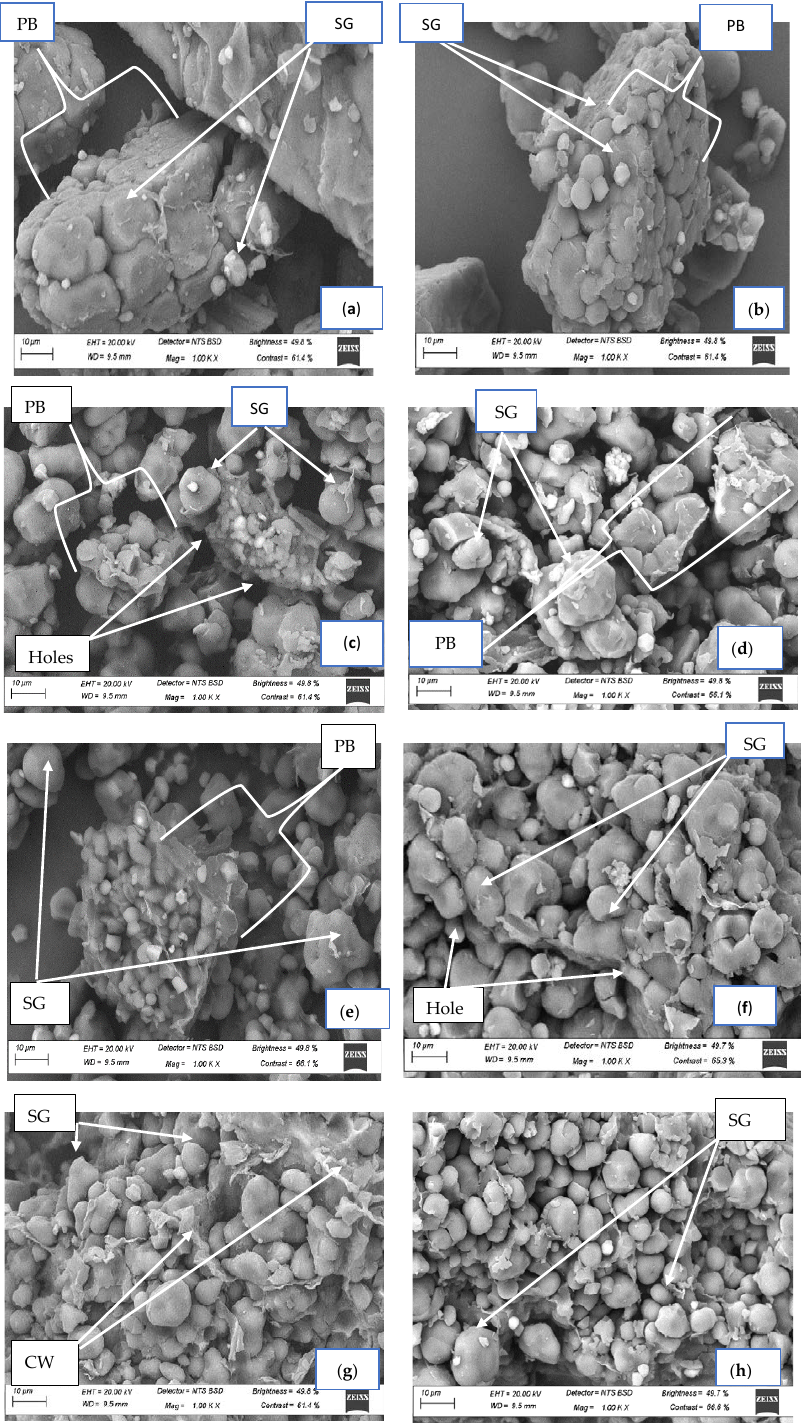
Figure 3. Scanning electron micrographs of fermented light- and dark-brown FMF: ( a ) native light-brown FMF; ( b ) native dark-brown FMF; ( c ) 24 h fermented light-brown finger millet; ( d ) 24 h fermented dark-brown FMF; ( e ) 48 h fermented light-brown FMF; ( f ) 48 h fermented dark-brown FMF; ( g ) 72 h fermented light-brown FMF; ( h ) 72 h fermented dark-brown FMF; PB = protein bodies; SG = starch granules; CW = cell walls; FMF = finger millet flours.